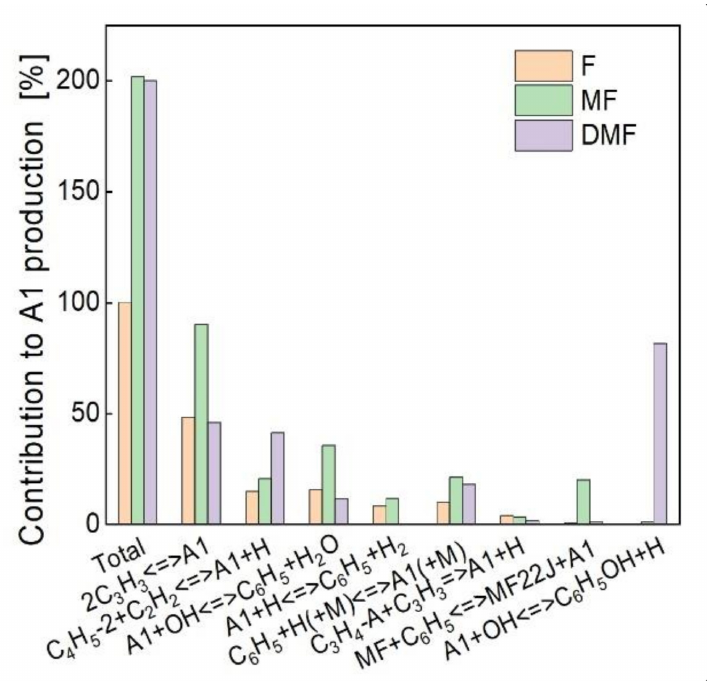
Figure 9. Percentage contribution to the A1 production from each reaction for furan, MF, and DMF flames (X F = 0.2 and X O = 0.25). Here, MF22J is